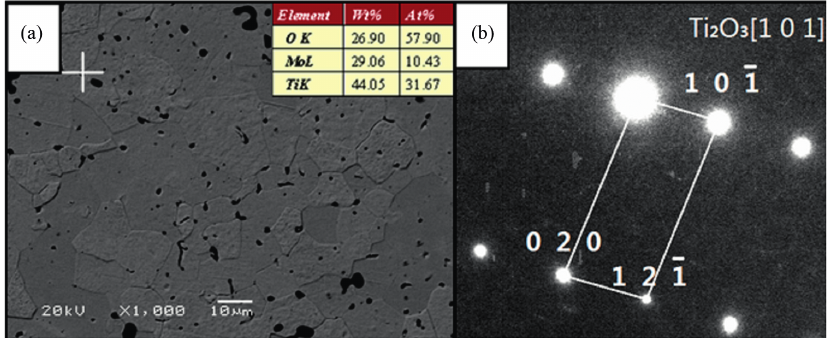
Figure 3: SEM image of Mo-0.5Ti and EDS patterns of the second phase.